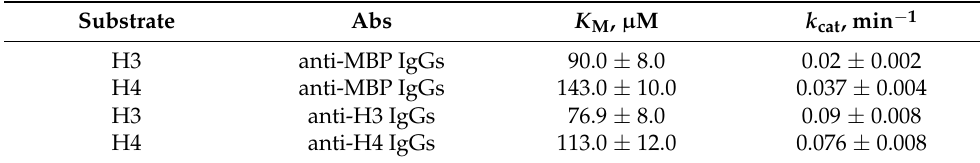
Figure 9. Determination of the values of K m and V max ( k cat ) for H3 and H4 substrates in their hydrolysis by IgGs against MBP ( A ) and ( B ), respectively; 0.04 mg/mL) and by abzymes against H3 ( C ); 0.022 mg/mL) and H4 ( D ; 0.02 mg/mL) using a Lineweaver-Burk plot. The average error in the initial rate estimation at each substrate concentration from two independent experiments did not exceed 10%–20%. Table 1. The K m and k cat values for H3 and H4 histones